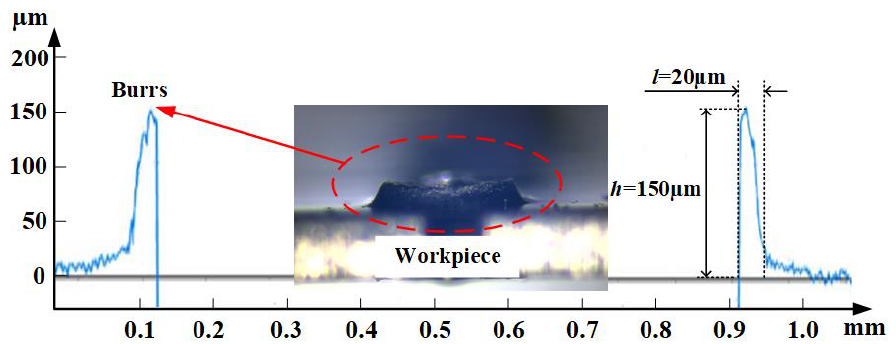
Figure 3. The final measured burr height is h = 150 µ m and the burr thickness is l = 20 µ m.